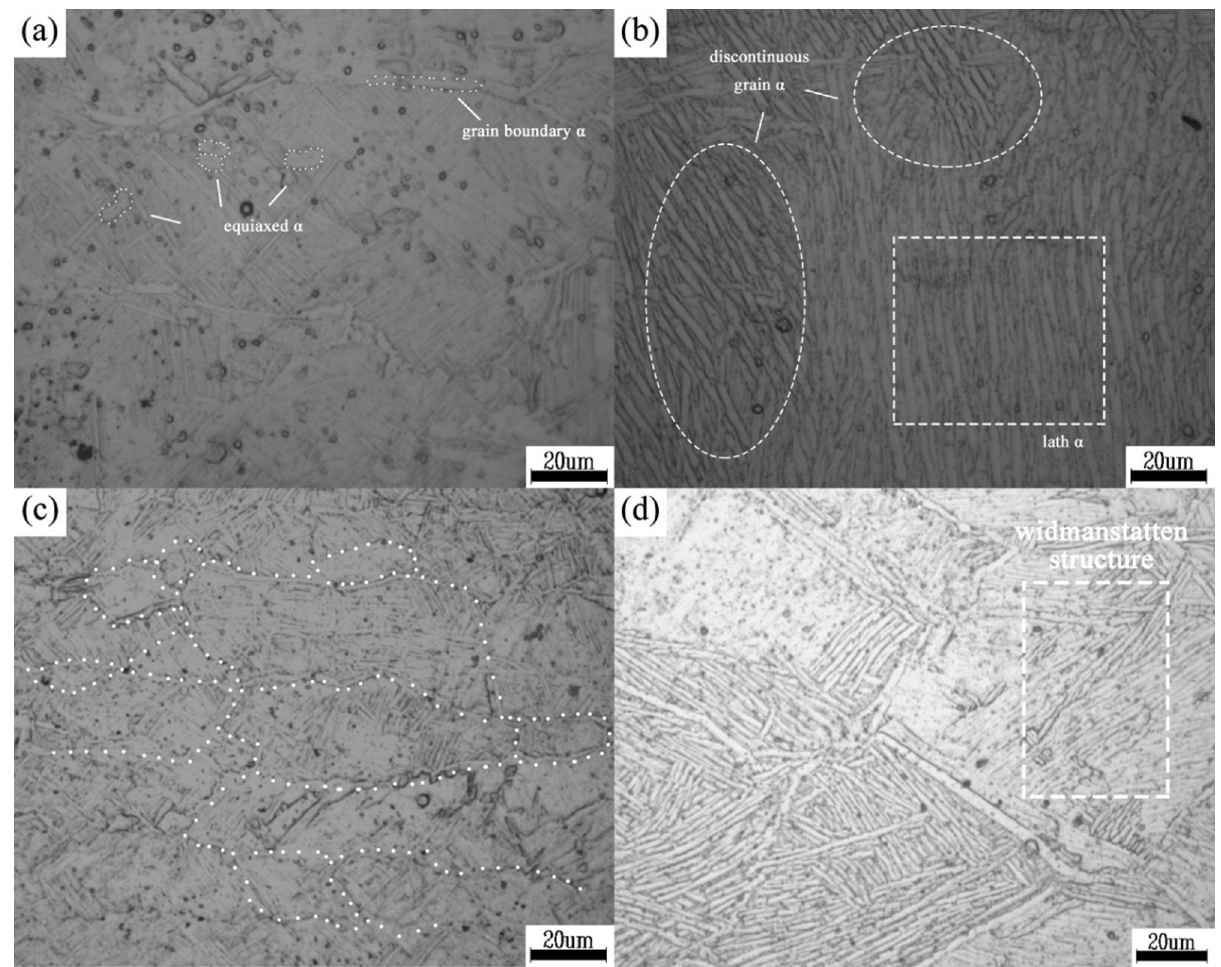
Figure 9: The OM at 950°C: ( a ) 0.01 s − 1 ; ( b ) 0.1 s − 1 ; ( c ) 1 s − 1 and ( d ) 5 s − 1